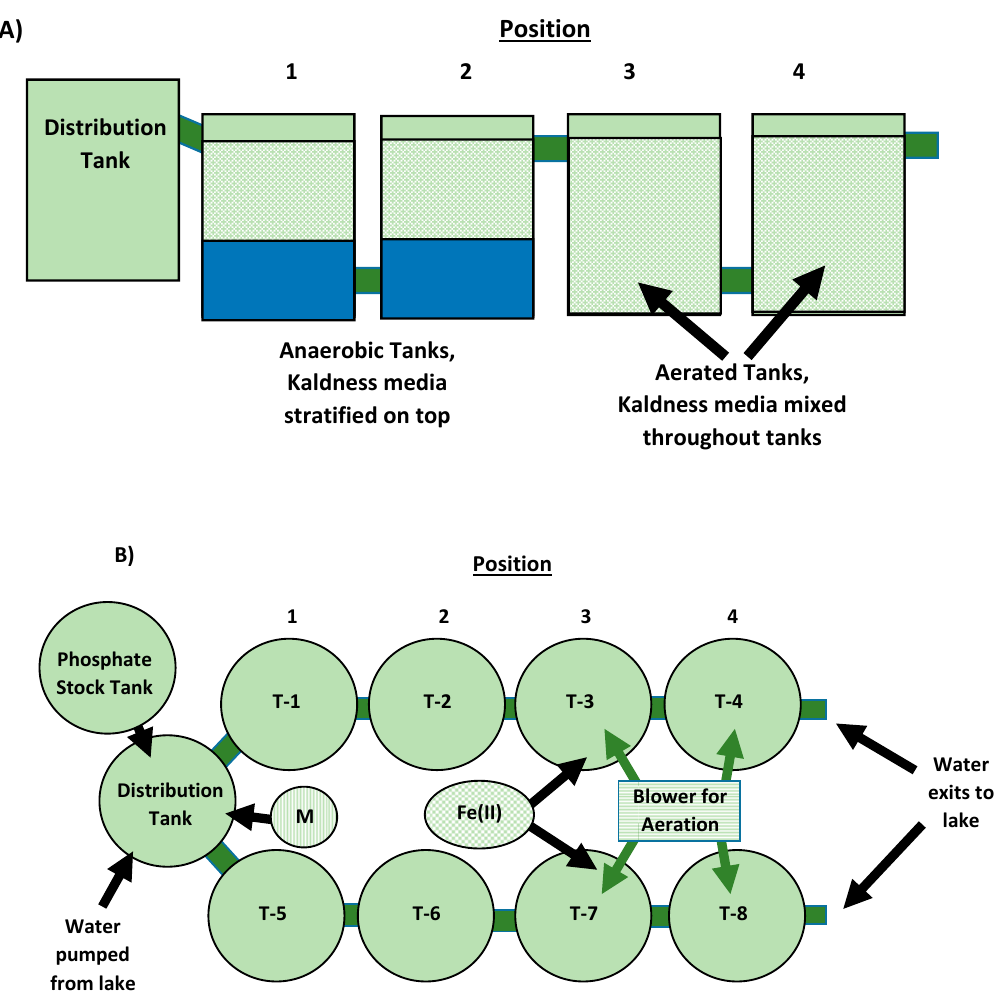
Figure 1. Diagram of bioremediation treatment-train system. ( A ) Side view showing tank profiles, positions, Kaldness media positions, and connections between tanks in each position. ( B ) Top view of replicate systems showing water inflow and outflow points and points for FeSO 4 , air, and nutrient injections. T = tank; M = molasses tank; Fe(II) FeSO 4 injection. Duplicate bioreactor systems were connected to the distribution tank using 5.08 cm i.d. polyvinyl chloride (PVC) fittings and pipes. Each bioreactor system consisted of four 242 L inter-connected